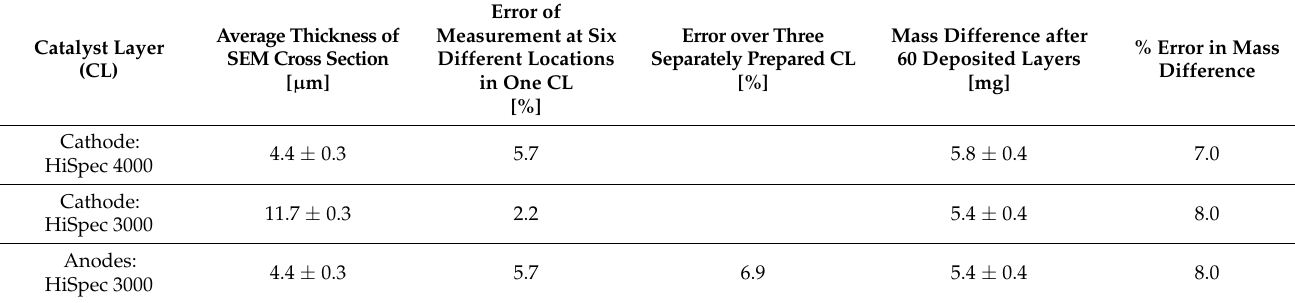
Table 2. Thickness and mass change of catalyst layers (anode and cathode) calculated from cross-sectional SEM images of MEA 40/0.125, MEA 20/0.125 and three purposefully prepared anodes, using the same composition as the HiSpec 3000 cathode, with 0.05 mg Pt cm − 2 loading. The mass-change experiment was repeated three times for each catalyst. Catalyst Layer